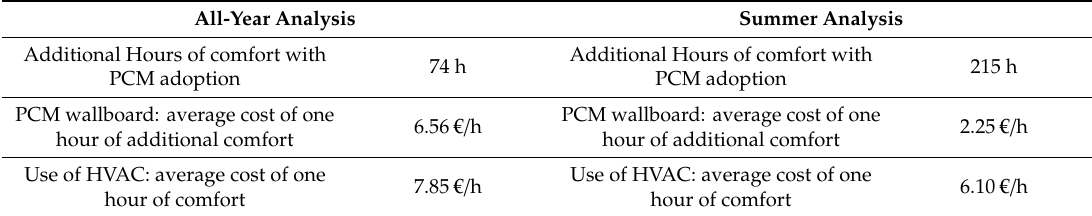
Table 5. Costs of additional hours of comfort during a year and during the